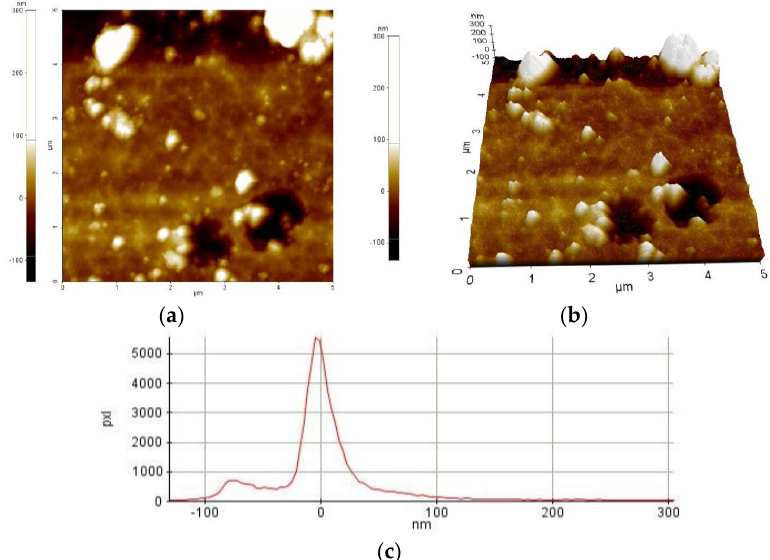
Figure 3. AFM surface topography of AlCrN coating: ( a ) 2D image; ( b ) 3D image; ( c ) region histogram.